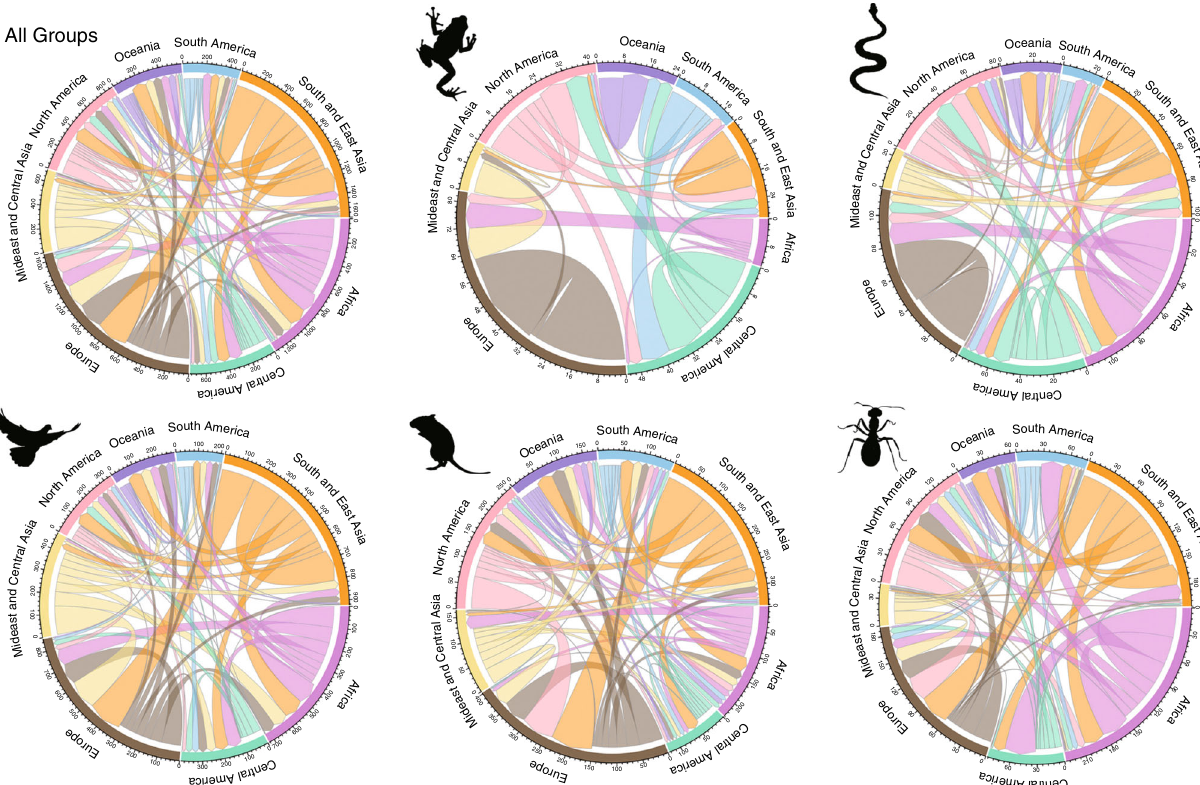
Fig. 3 Chord diagram showing the global fl ows of established alien animals in PAs from native to alien continents across taxa. Colours indicate different continents where the species are native. The width of a chord represents the number of establishments. The size of the outer circle segments indicates the total number of establishments in or originating from the continent. Credit: Tianjian Song (animal